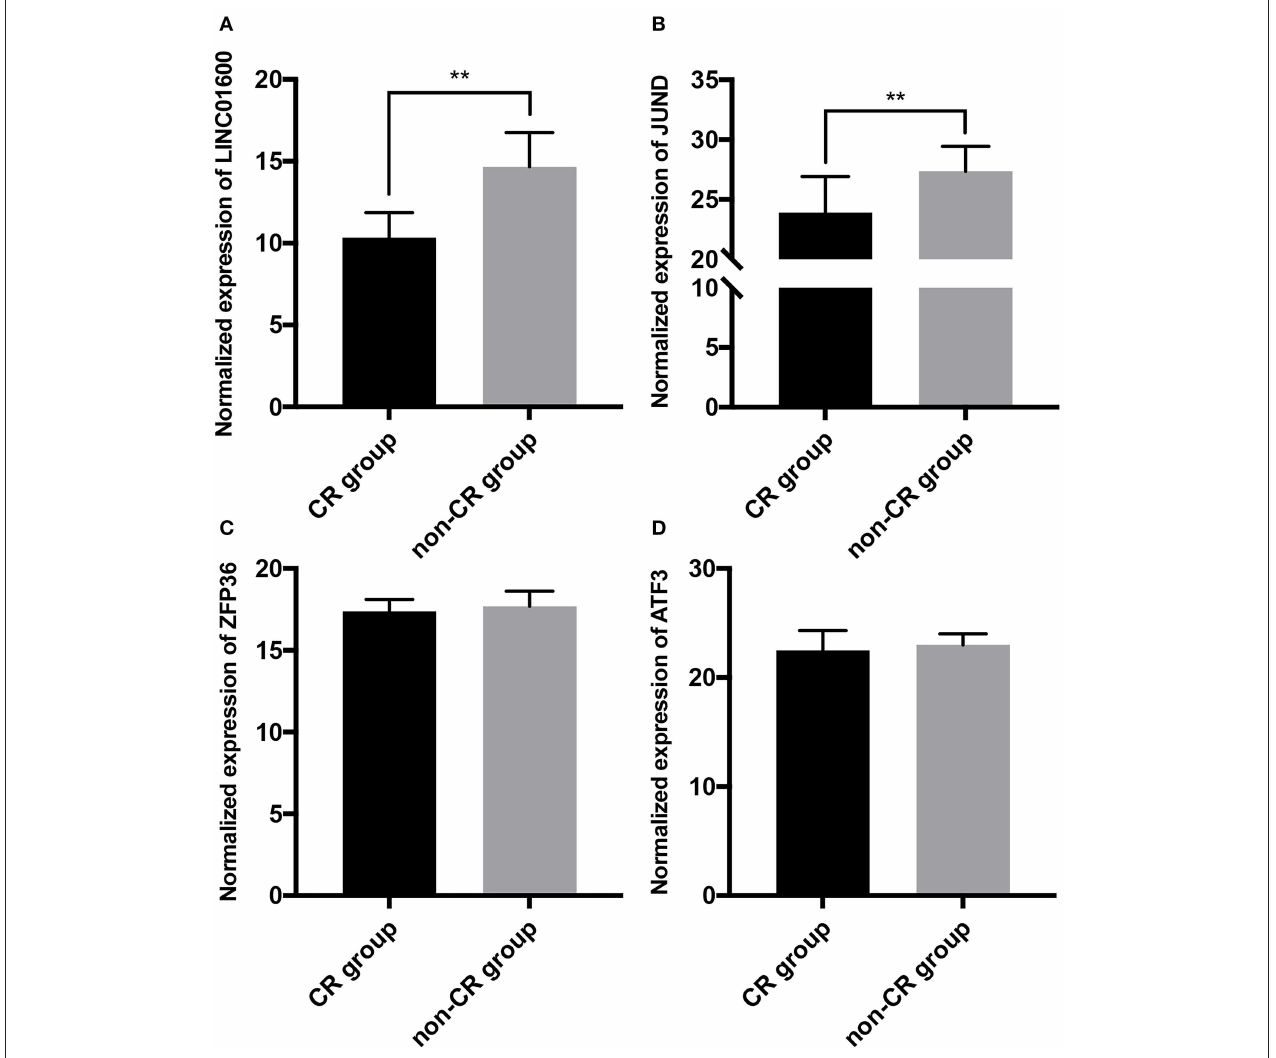
FIGURE 6 | The expression of (A) LINC01600, (B) JUND, (C) ZFP36, and (D) ATF3 is detected by RT-qPCR in tumor tissues of 40 PCa patients collected in our hospital. LINC01600 and JUND are significantly upregulated in non-CR group compared with CR group. There is no differential expression of ZFP36 and ATF3 between CR group and non-CR group (** P <